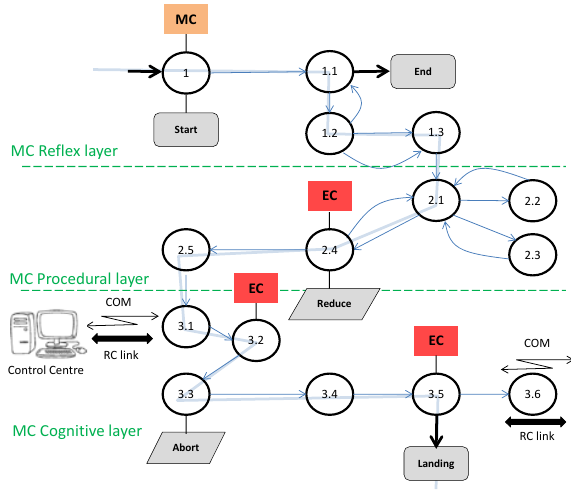
Figure 4: Operation modes and resource adaptation